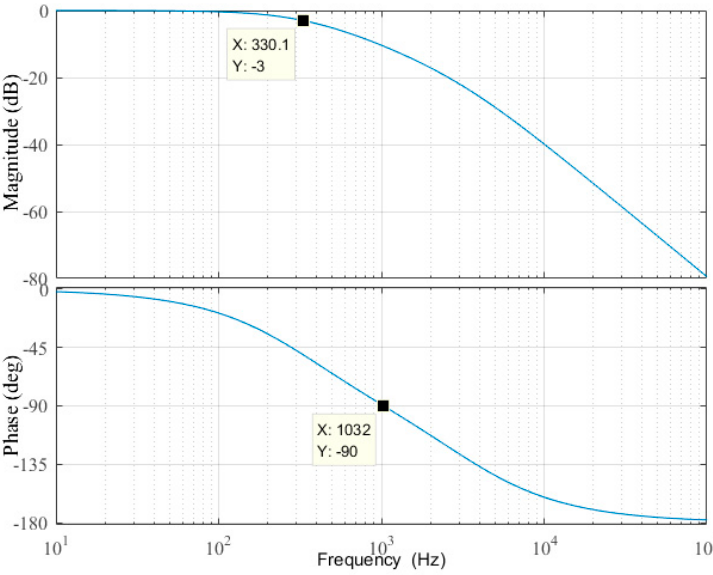
Figure 12. Bode diagram of the system.